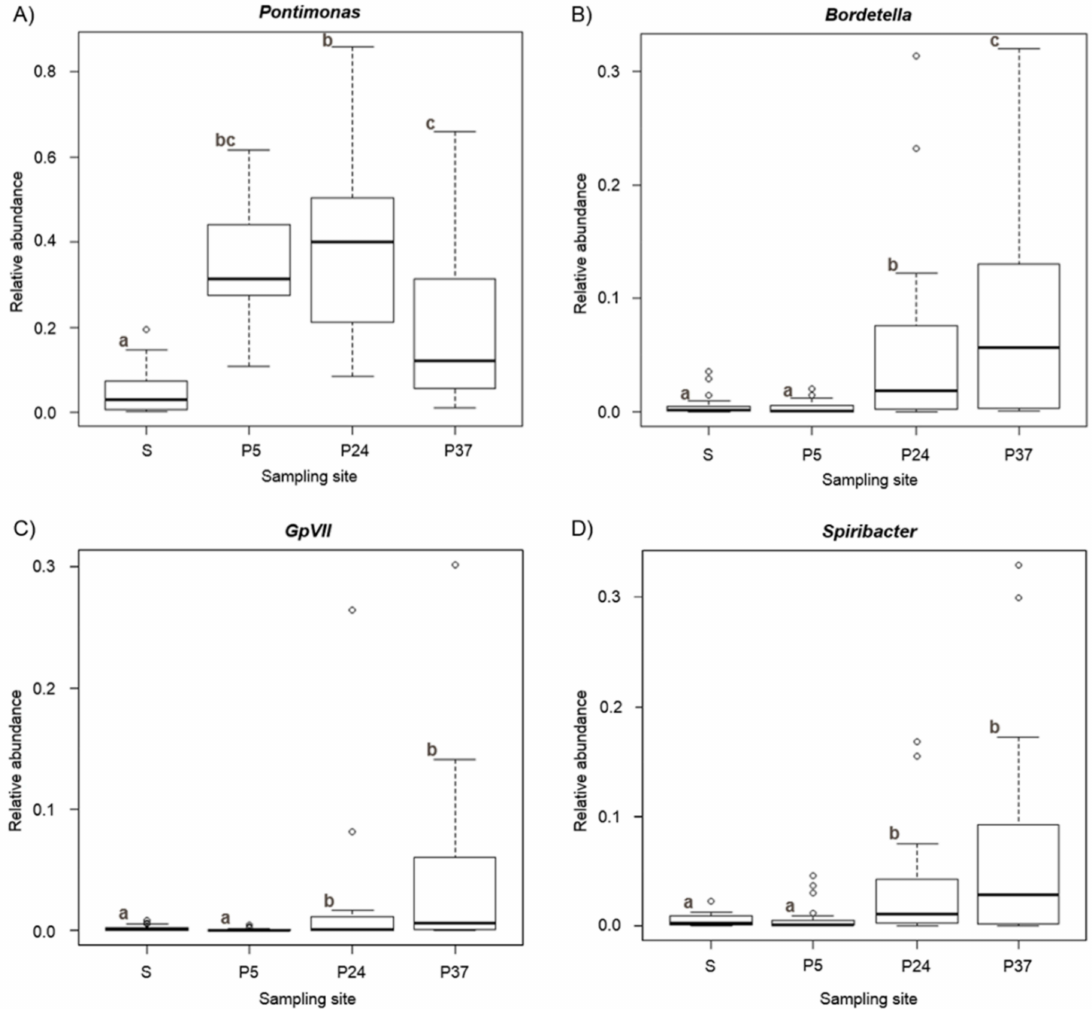
Figure 4. Box-whisker plot (Generalised Linear Model (GLM) analysis) showing abundance variation of Pontimonas ( A ), Bordetella ( B ), GpVII ( C ) and Spiribacter ( D ) across the sampling sites. The thick lines represent the median, boxes’ upper and lower limits indicate the 25th and the 75th percentiles respectively, whiskers indicate the data that go beyond the 5th percentile (lower whisker) and the 75th percentile (upper whisker), and dots represent the outliers. Different letters indicate differences between the mean values of different